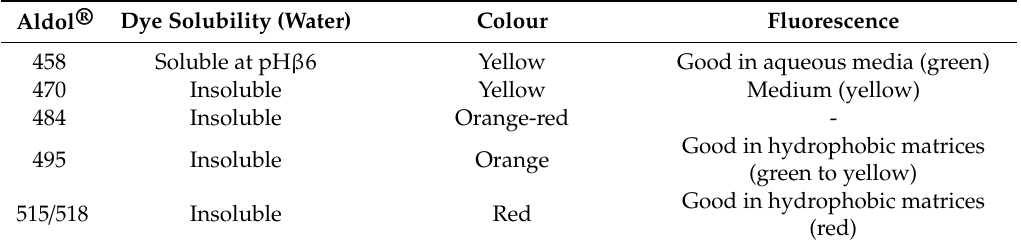
Table 2. Aldol ® products key features.